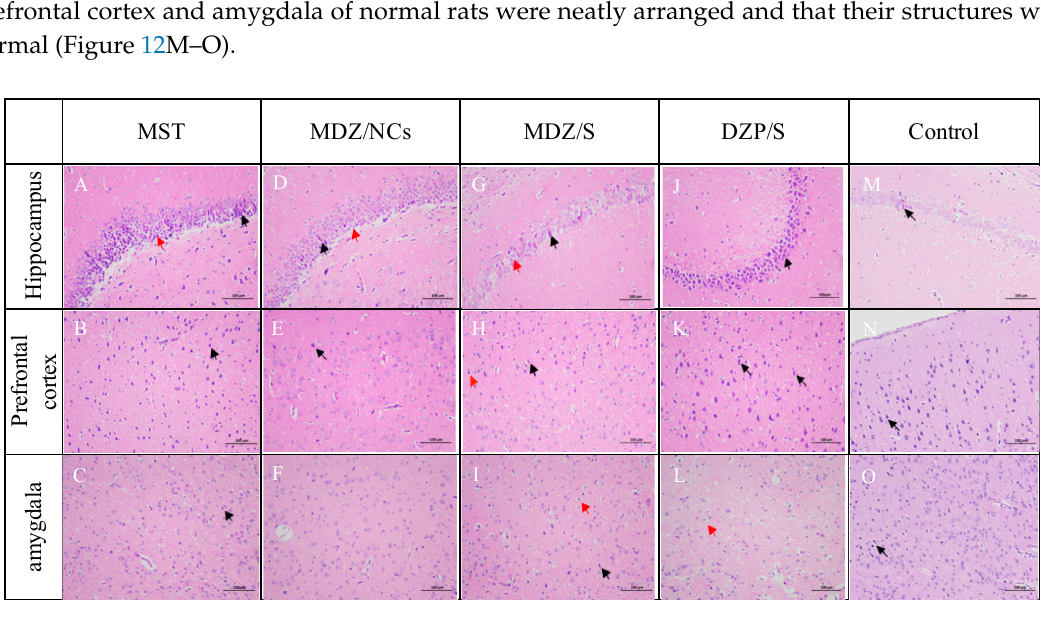
Figure 13. ( A ) Effect of MDZ/NCs on the MDA levels in the hippocampus of MST-induced convulsive rats. ( B ) GSH; ( C ) SOD. Note: The data represent the mean ± SD (n = 6); * p < 0.05; ****p < 0.01 compared with the MDZ/NC model group. Abbreviations: MDA, malondialdehyde; GSH, glutathione; SOD, superoxide dismutase.